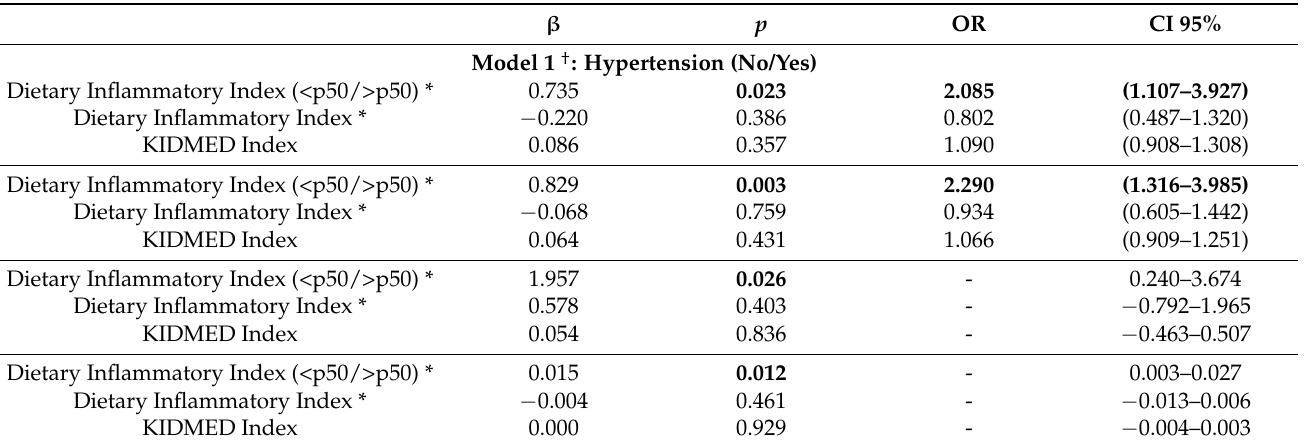
Table 6. Associations between the Dietary Inflammatory Index, nutritional status, and cardiovascular risk factors in